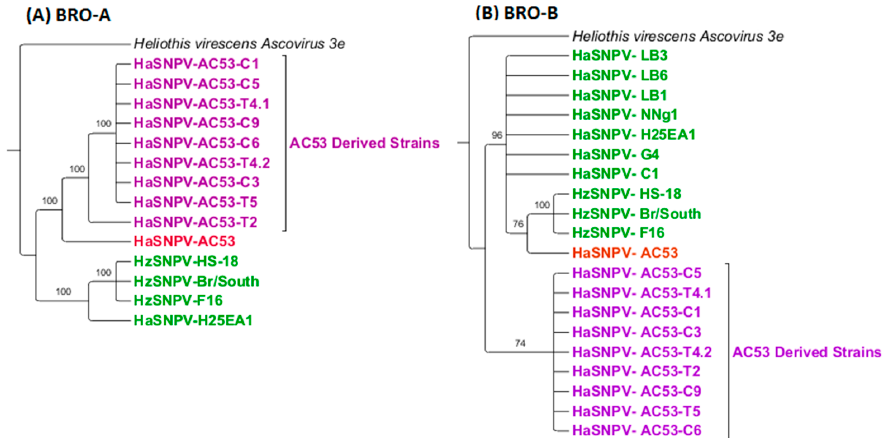
Figure 4. The root for both trees is the Heliothis virescens Ascovirus 3e isolate and have been collapsed based on 70% bootstrap support. ( A ) baculovirus repeated open reading frame (BRO) ‐ A maximum likelihood estimation (MLE) identified two distinct clusters, AC53 derived and non ‐ AC53 derived; ( B ) BRO ‐ B also identified two distinct clusters, however the parent AC53 strain was grouped with non ‐ AC53 derived. A third group in BRO ‐ B consisting of HzSNPV isolates could also be identified.